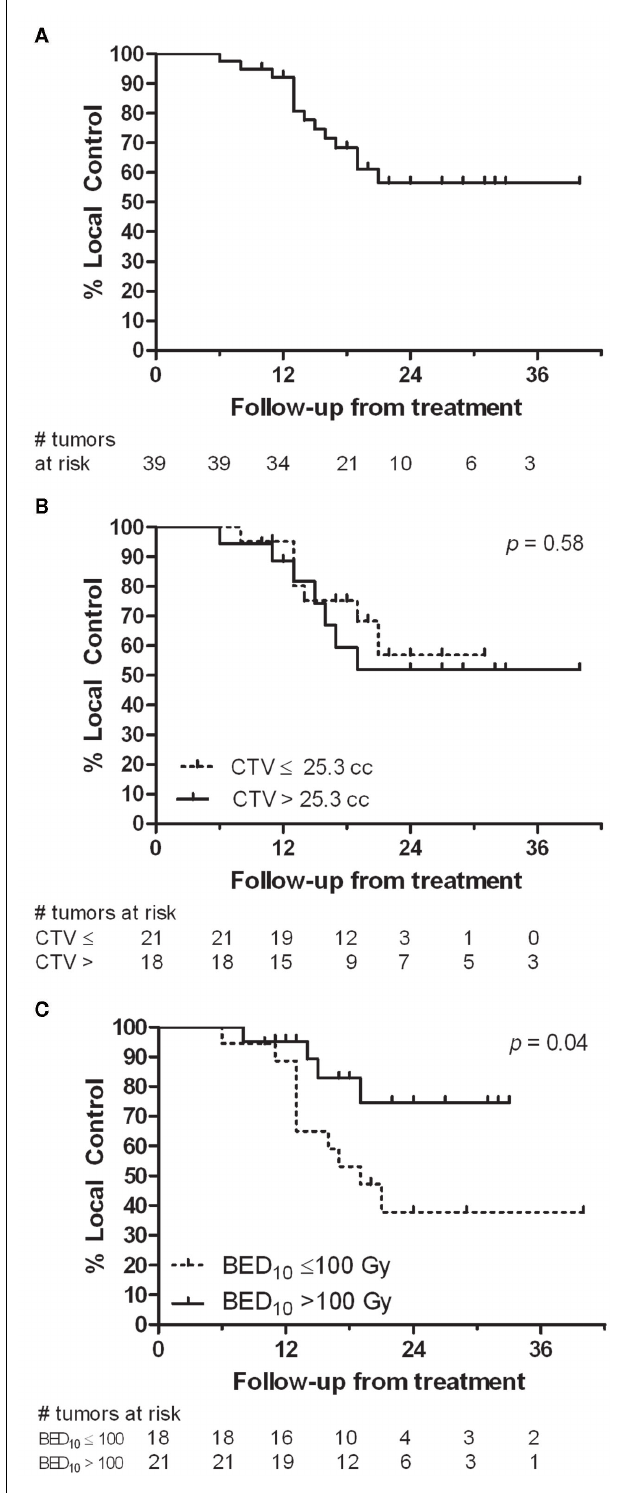
FIGURE 2 | Local control analysis (A) from time of SBRT. (B) Comparison of local control for tumors with a CTV ≤ 25.3cc to those with a CTV > 25.3cc. (C) Comparison of local control for those tumors receiving a BED10 of ≤ 100Gy10 to those receiving a BED10 >